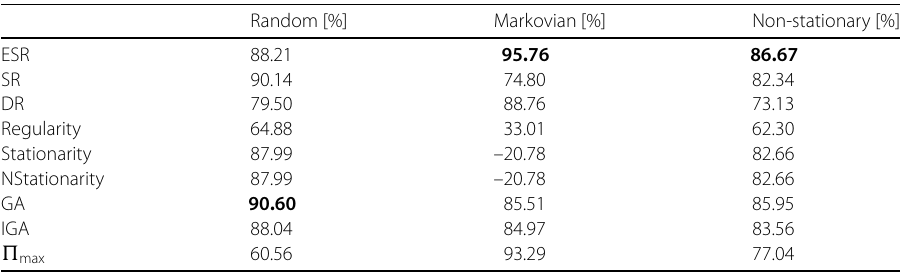
Table 5 Spearman’s correlation of the evaluated metrics and accuracy of predictions calculated on the three types of synthetic sequences Random [%] Markovian [%] Non-stationary [%] ESR 88.21 95 .